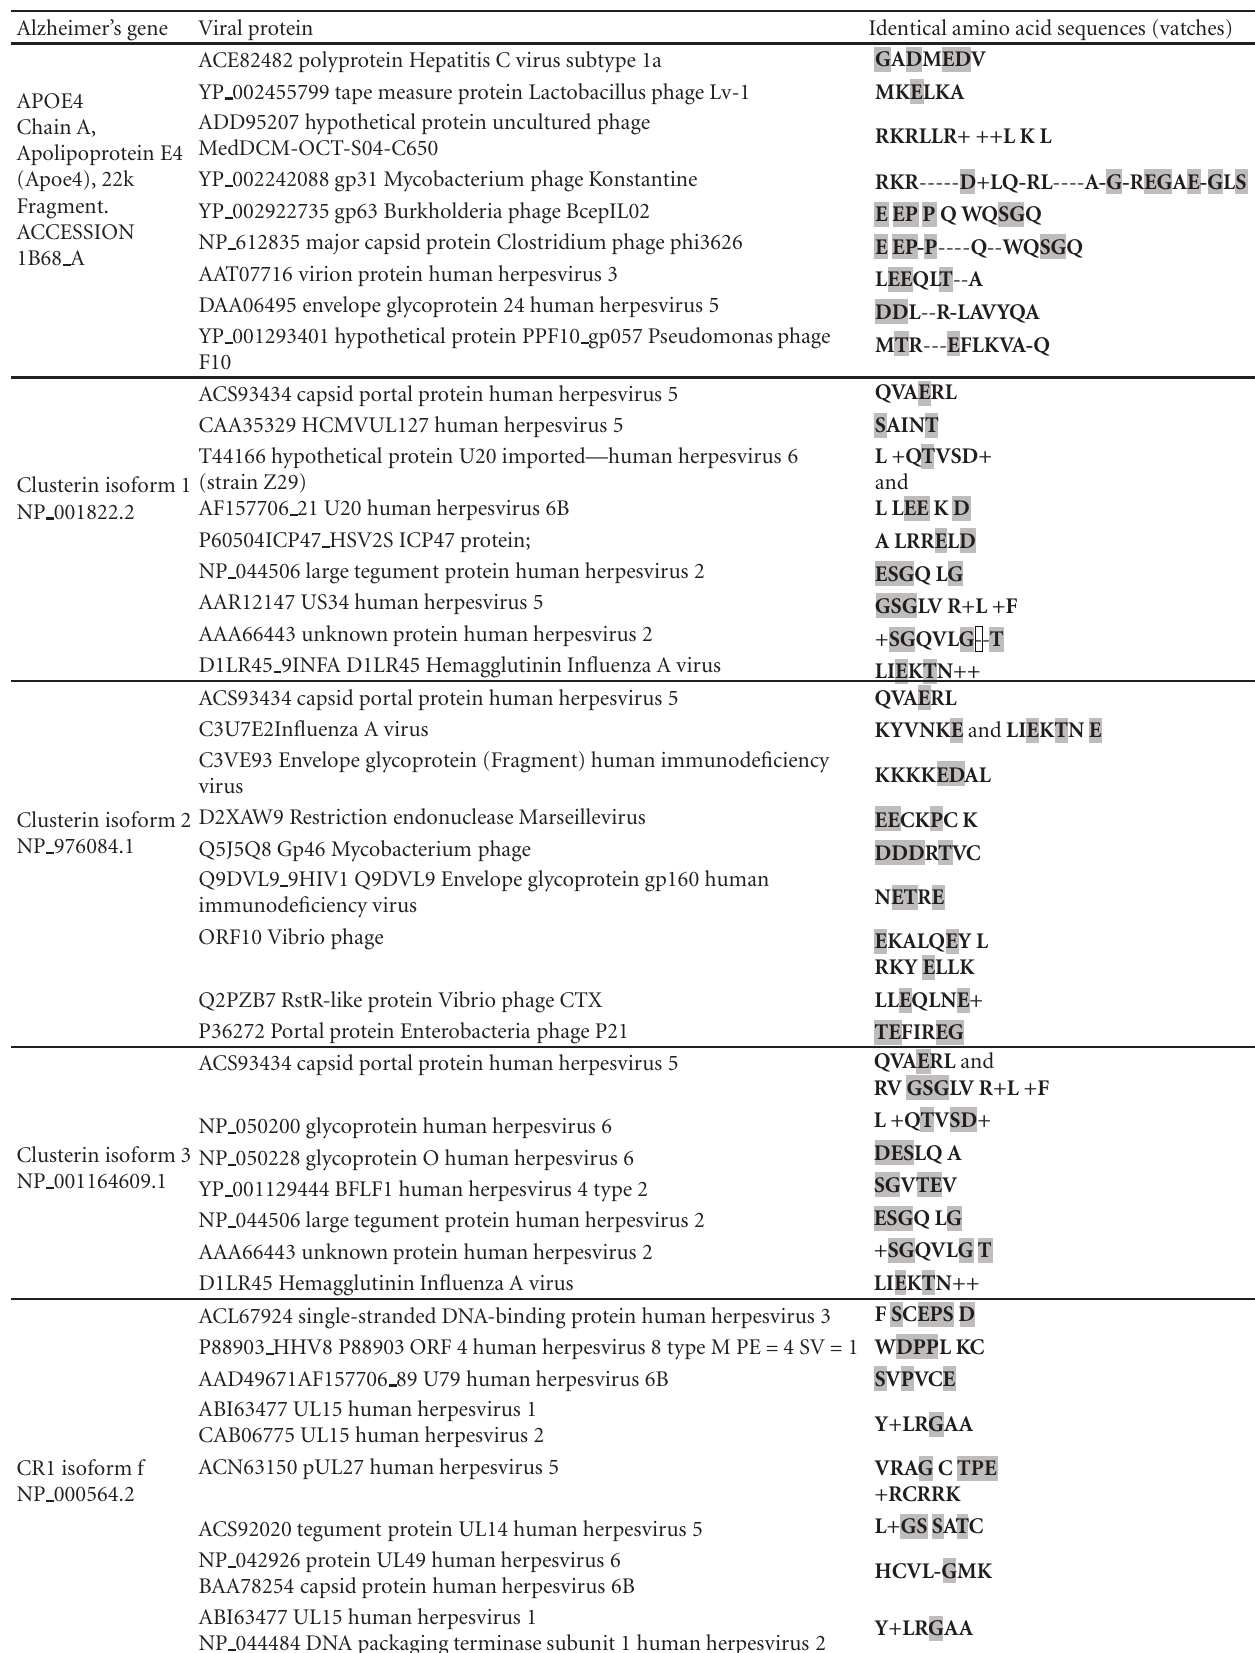
Table 5: Other viruses expressing homologous proteins for the four major Alzheimer’s disease susceptibility gene